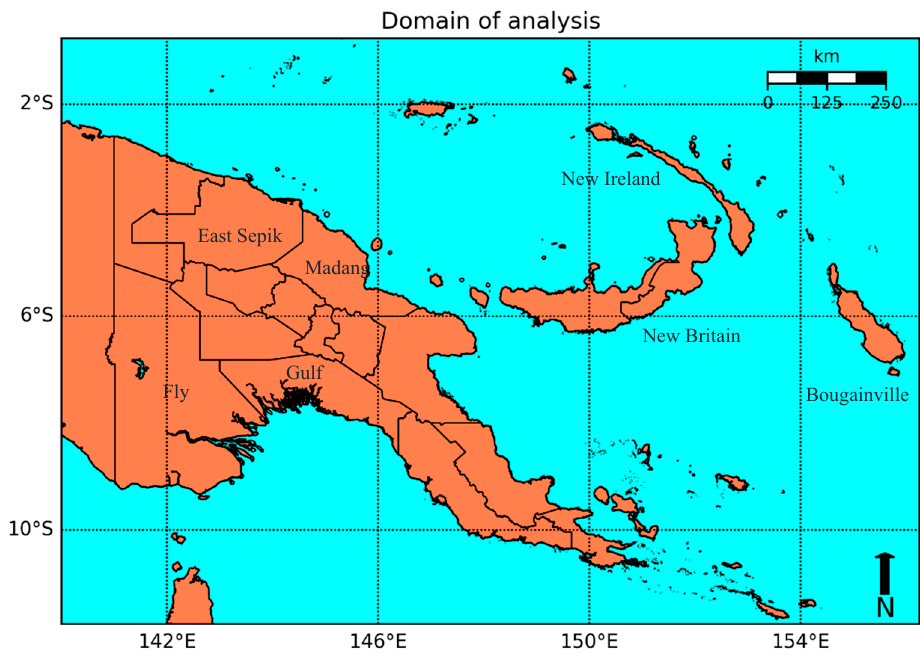
Figure A1. Political map showing regions referenced in this study.